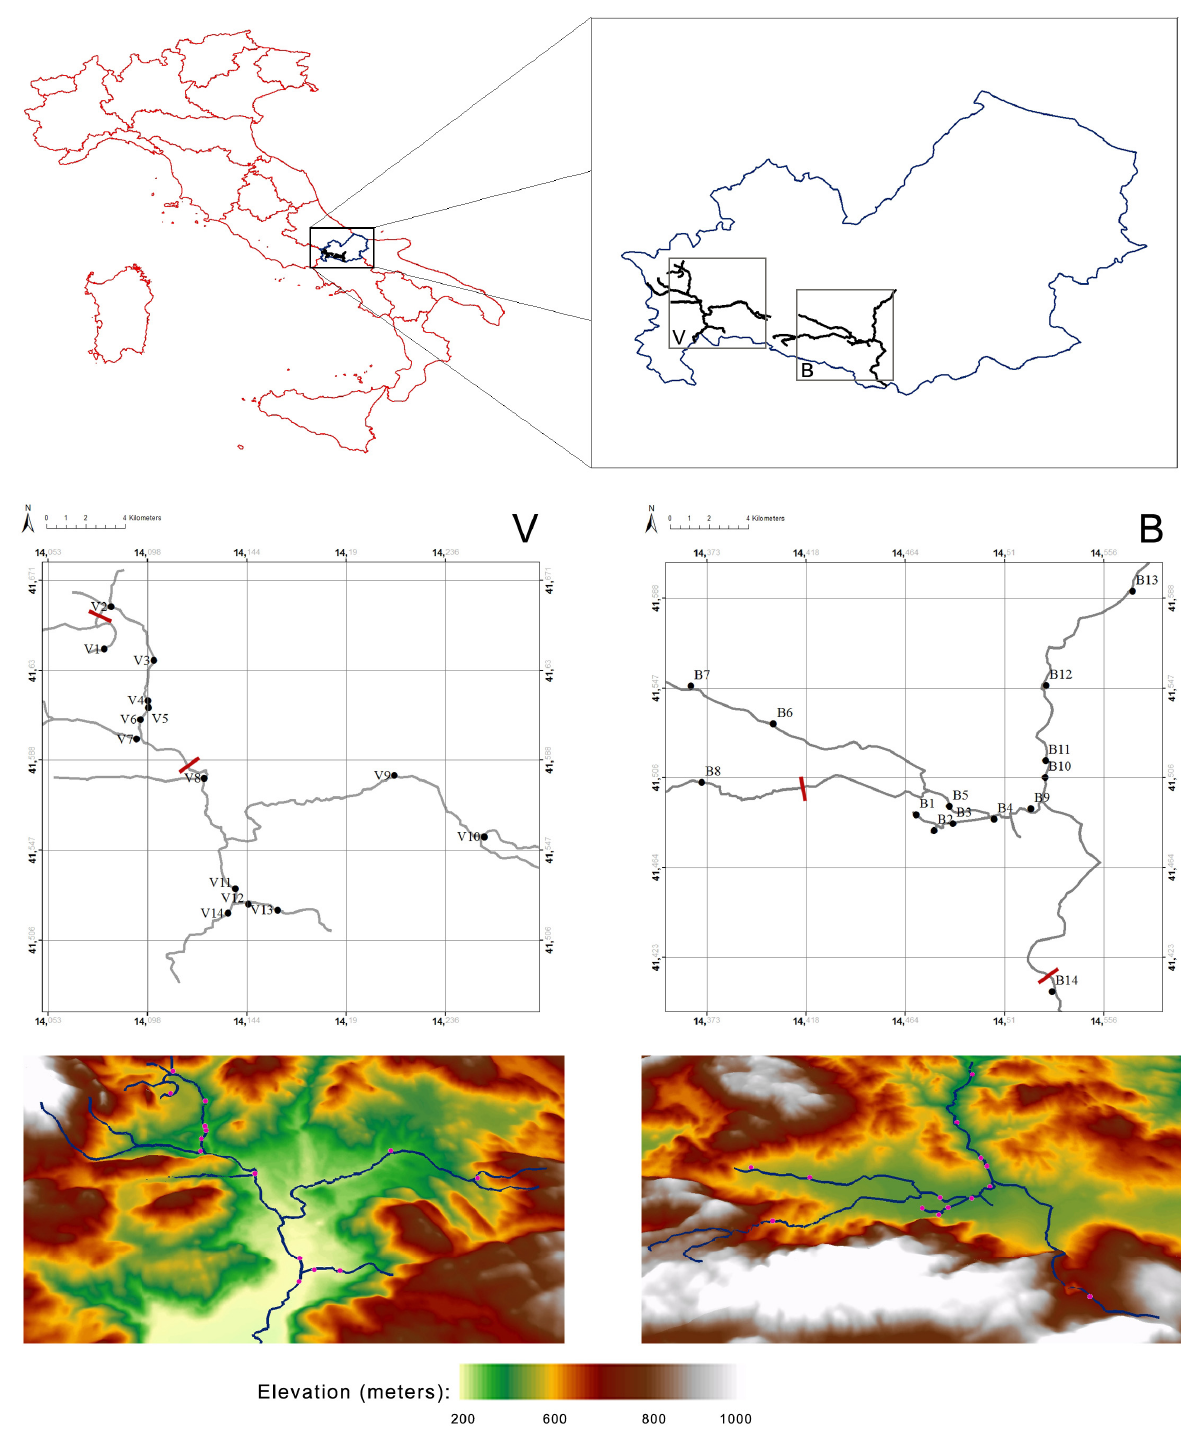
Figure 1. Maps showing trout sampling locations in Volturno (V) and Biferno (B) rivers. Location codes are detailed in Table S1. Red lines represent natural and/or artificial impassable barriers.